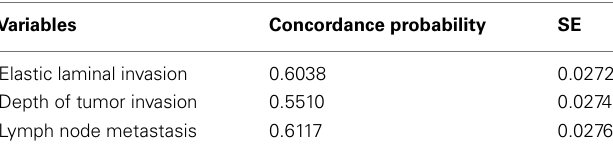
Table 1 | Estimated concordance